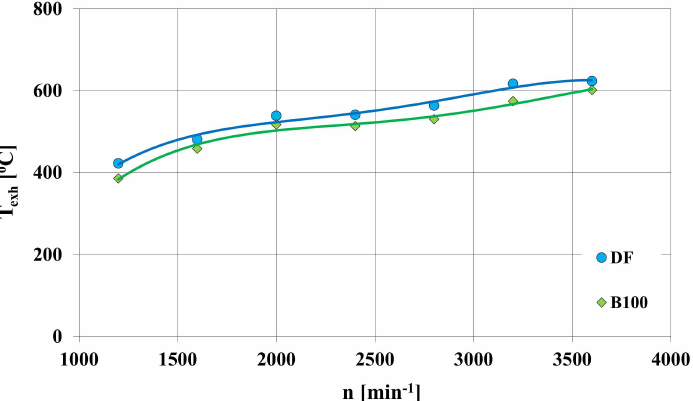
Figure 4. External speed characteristics of the temperature of exhaust gas -T exh in the rotation speed domain-n for the engine powered with fuels DF diesel or